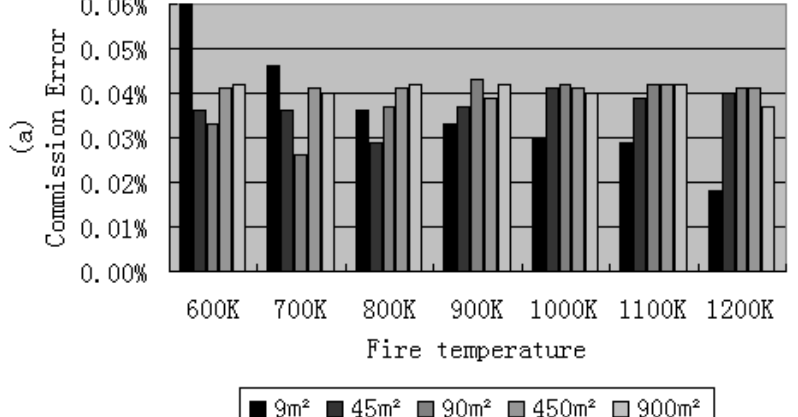
Figure 8. Commission errors of fire detection for different fire areas (m 2 ) and temperatures (K) Under the US standard atmospheric conditions with a visibility of 23 km. The solar zenith angles are 0 and 30 degree for (a) and (b),